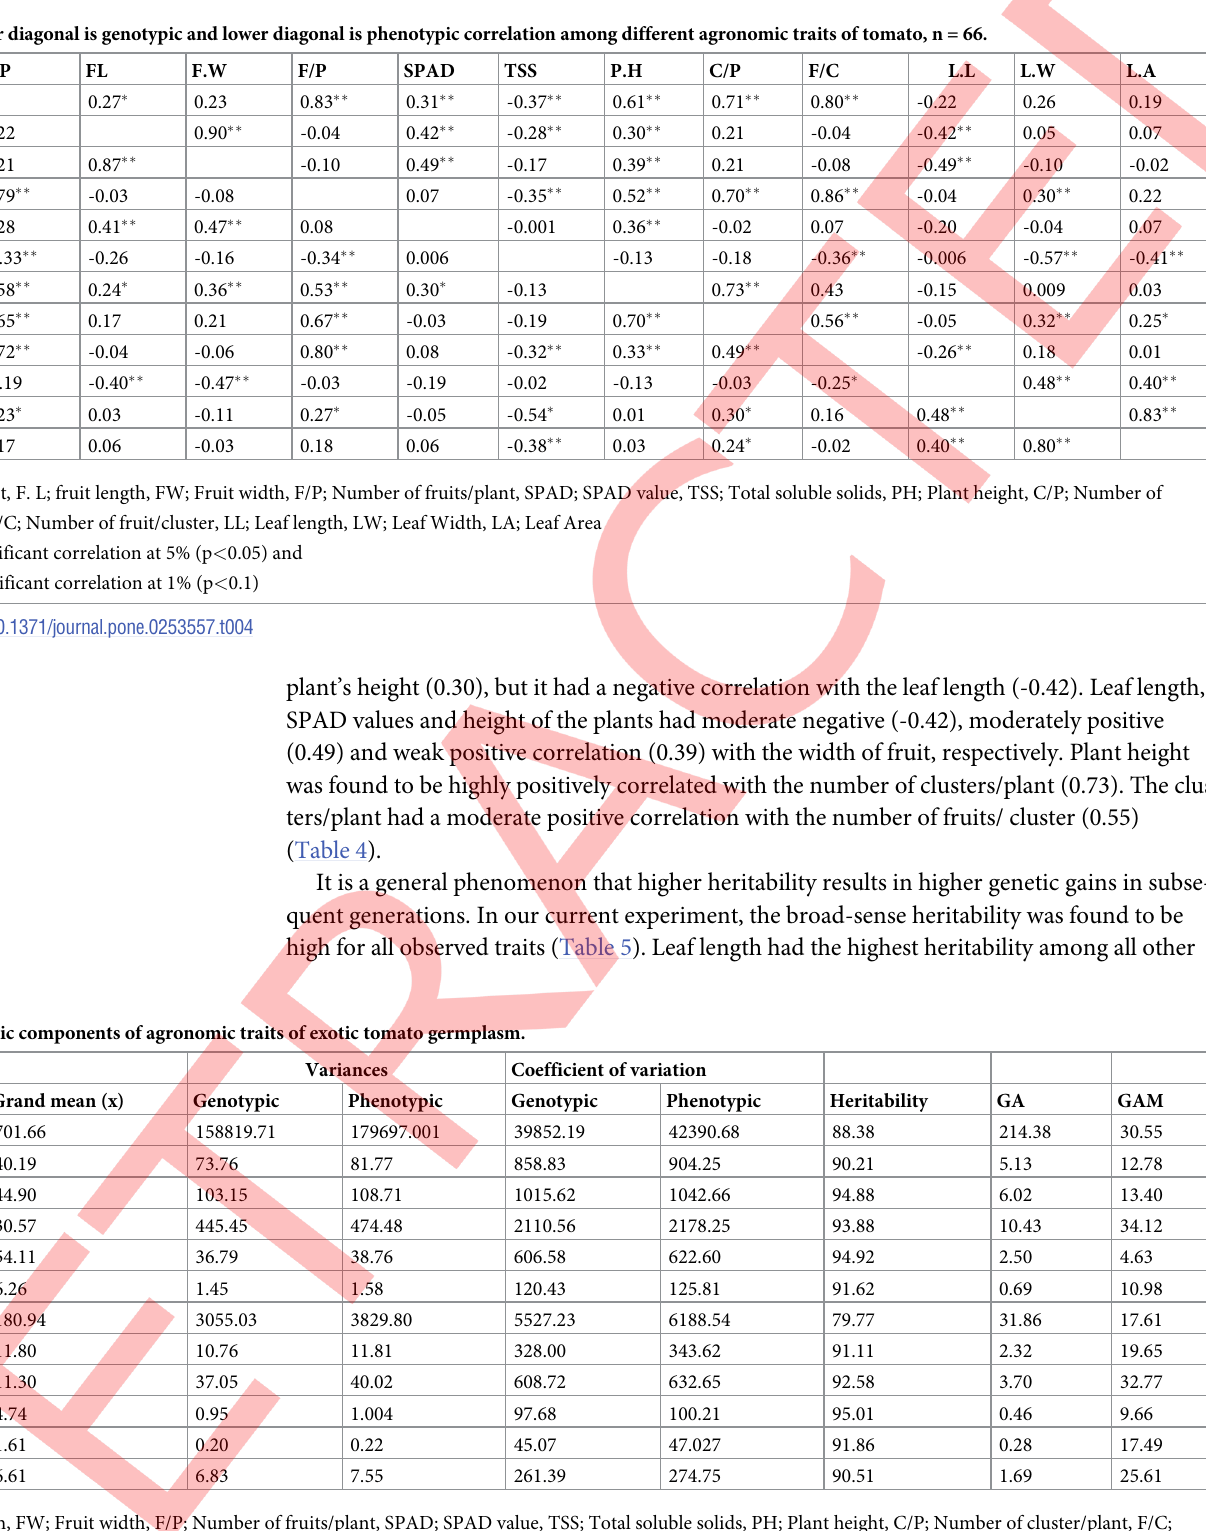
Table 4. Upper diagonal is genotypic and lower diagonal is phenotypic correlation among different agronomic traits of tomato, n = 66.